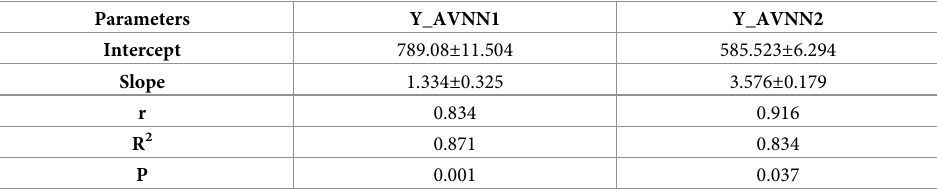
Table 5. Regression analysis of PPG signal parameter correlation.